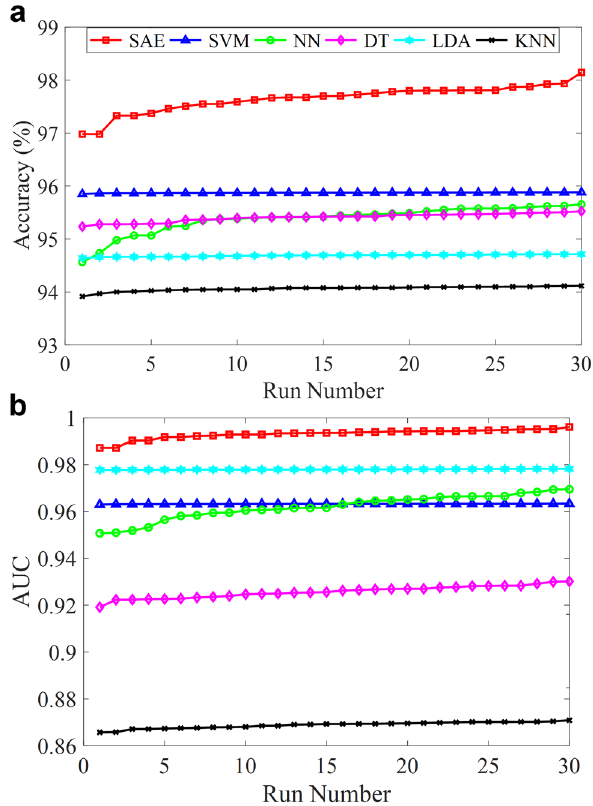
Figure 4. Performance comparisons of SAE-based DNN and traditional classifiers. ( a ) Accuracies of classifiers for 30 runs. ( b ) AUC values obtained from ROC curve of classifiers for 30